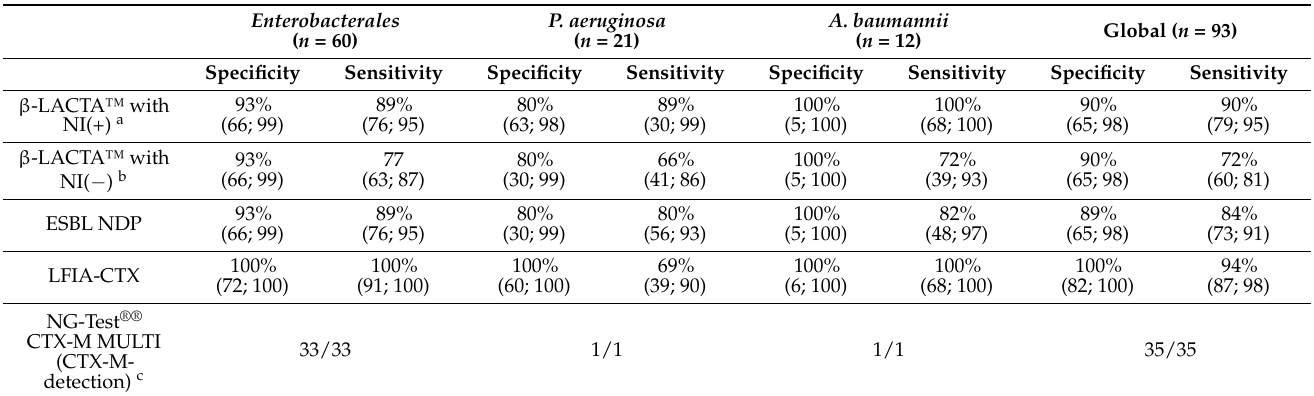
Table 2. Global performances of the β -LACTA ™ , ESBL NDP, LFIA-CTX, and NG-Test ® CTX-M MULTI tests on different isolates of Enterobacterales, P. aeruginosa , and A. baumannii. Values in brackets are the 95% confidence interval with alpha =